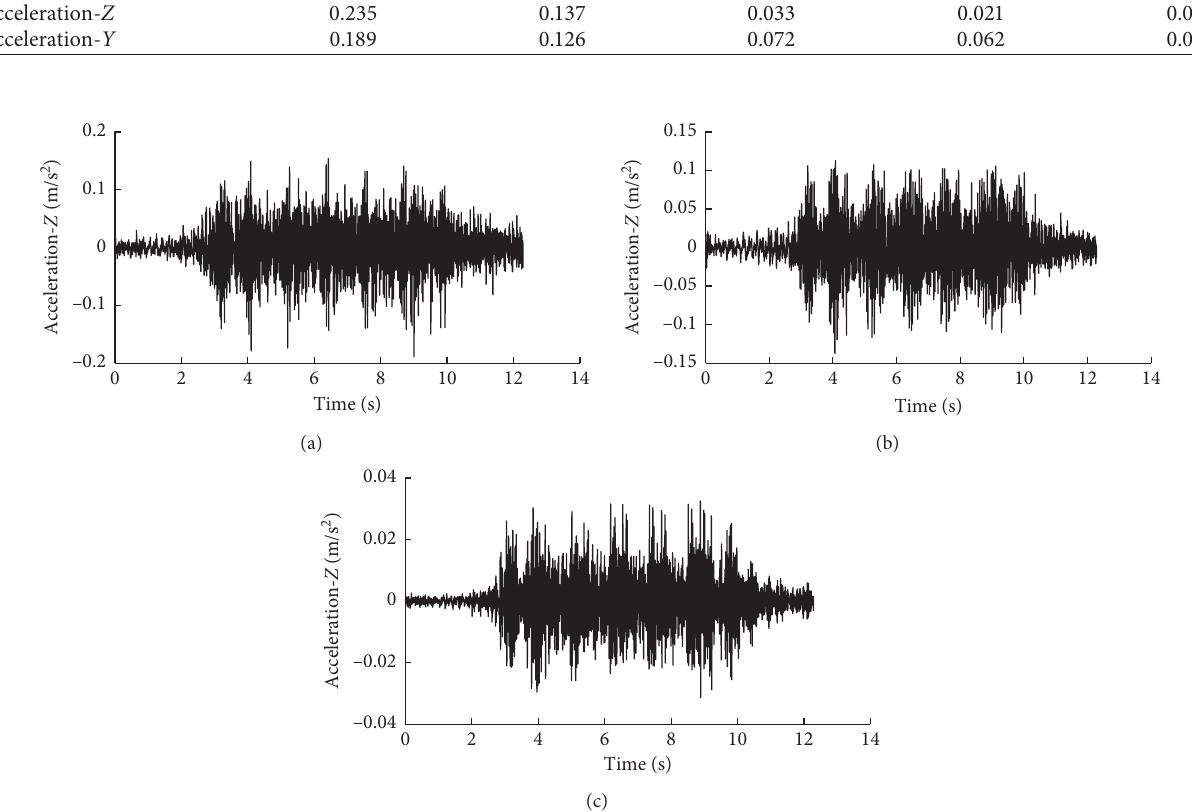
Figure 14: Time history curves of vertical on the ground surface: (a) A01; (b) A02; (c)